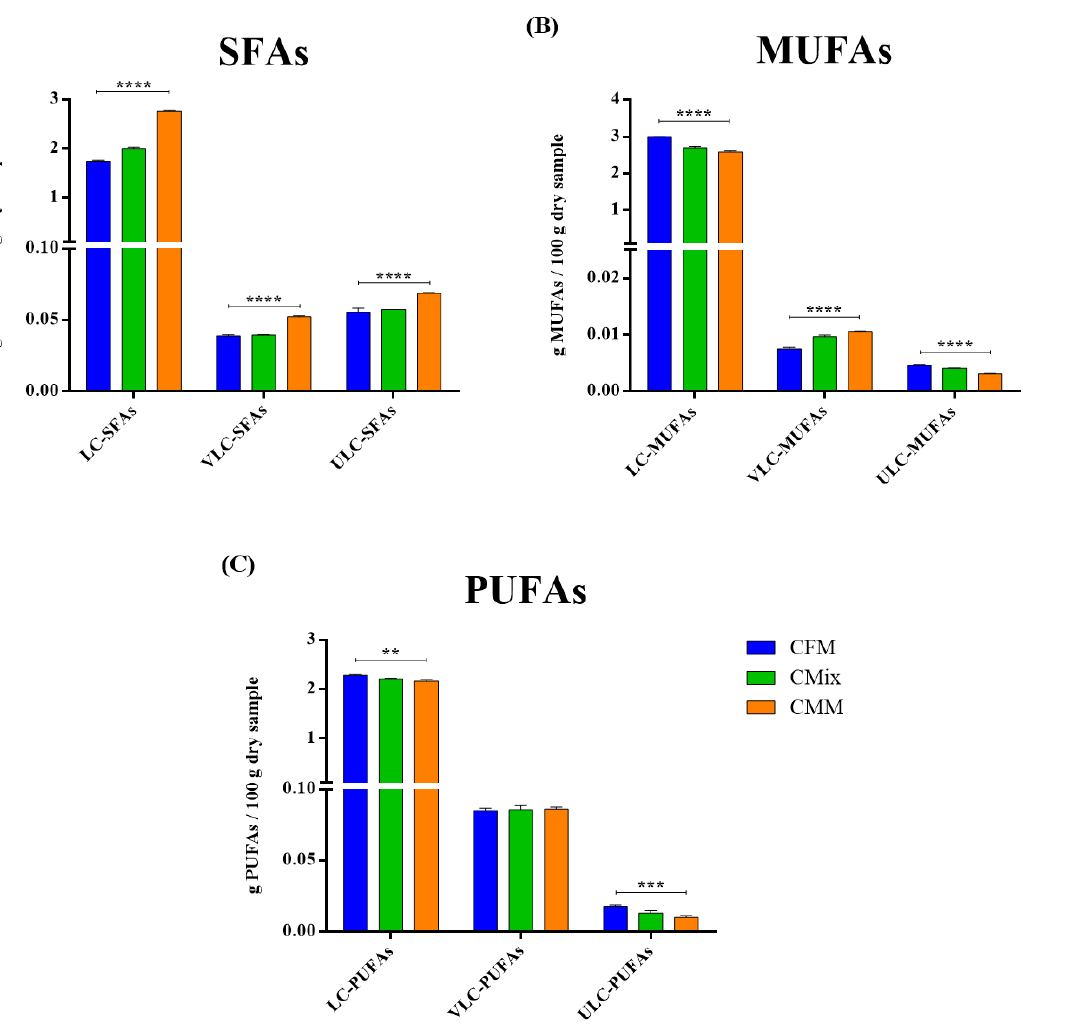
Figure 5. ( A ) LC-SFA, VLC-SFA, and ULC-SFA contents of CFM, CMix, and CMM formulations for companion animal food. ( B ) LC-MUFA, VLC-MUFA, and ULC-MUFA contents of CFM, CMix, and CMM formulations for companion animal food. ( C ) LC-PUFA, VLC-PUFA, and ULC-PUFA contents of CFM, CMix, and CMM formulations for companion animal food. Data are reported as mean ± SEM, n = 12. ** p < 0.01, *** p < 0.001, **** p < 0.0001.